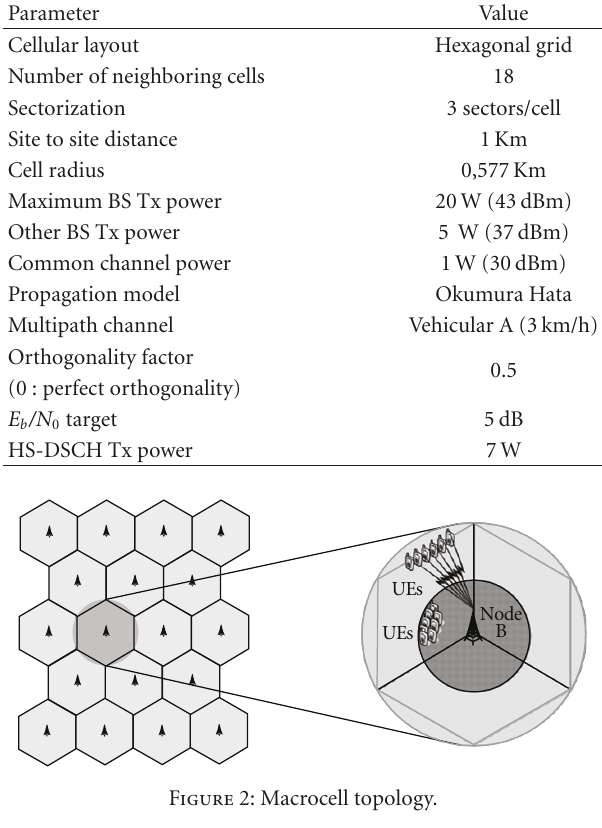
Table 2: Simulation assumptions.